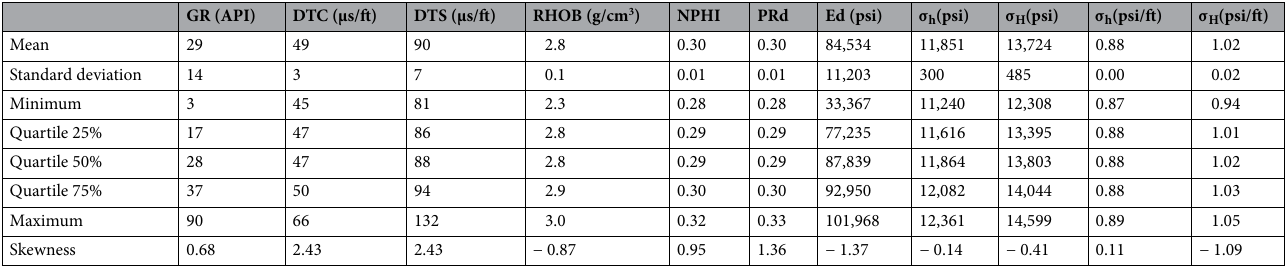
Table 1. Statistical analysis for the collected dataset for the two